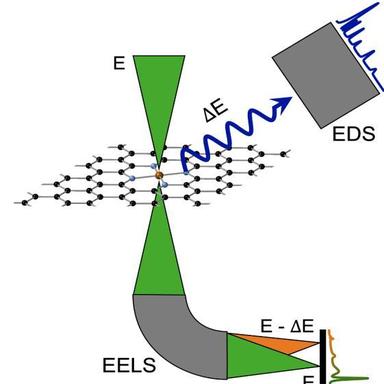
Schematic of simultaneous STEM-EELS and -EDS of a SAE metal site.